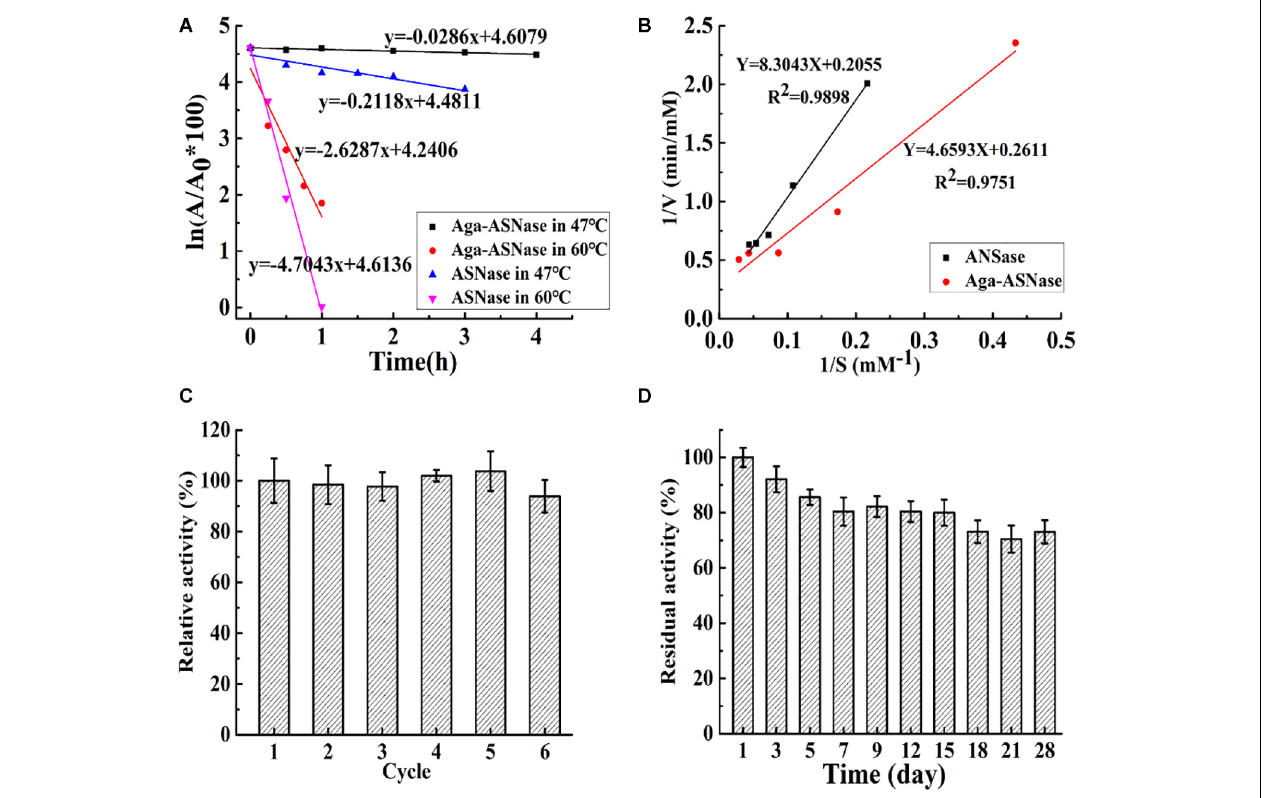
FIGURE 3 | (A) The half-life of asparaginase (ASNase) and Aga-ASNase at 47 and 60 ◦ C, respectively. (B) Kinetic parameters of ASNase and agarose (Aga)-ASNase at 37 ◦ C were detected using Lineweaver–Burk plots. (C) The enzymatic activity assay was conducted for six reaction cycles under the conditions 30 ◦ C, pH 7.5; the carriers were recovered and washed three times with phosphoric acid buffer (pH 7.5) after each cycle, then reintroduced to the next cycles. (D) The catalytic activity was measured under optimal conditions (37 ◦ C, pH 7.5) for 28 days after each experimental cycle, and the catalyzer was stored at 4 ◦ C with phosphoric acid buffer (pH